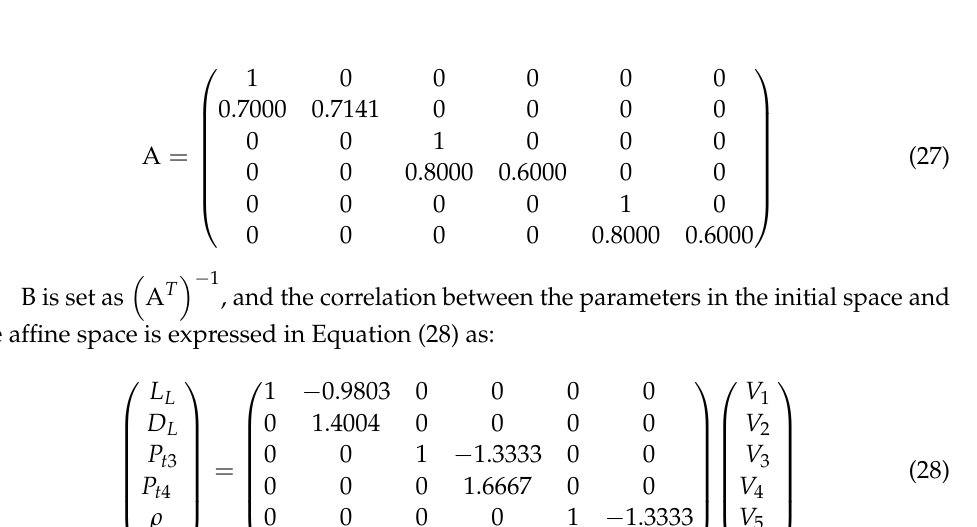
Table 4. Areas of the p-box of OTDF and the sensitivity index S of the corresponding input parameters.